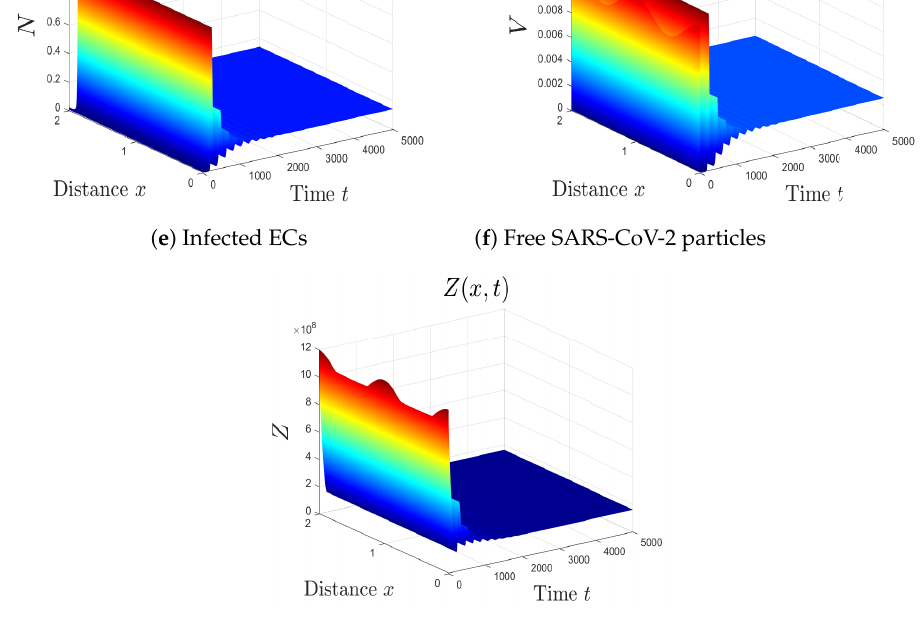
Figure 5. Simulation of system (1) for ( β m , β v , p 1 , p 2 , d 7 ) = ( 2 × 10 − 10 ,0.9,3 × 10 − 8 ,3.9,0.01 ) . The equilibrium E 4 = ( 10 × 10 9 ,0,0,6.775,0.1421,0.0026,1.628 × 10 8 ) is